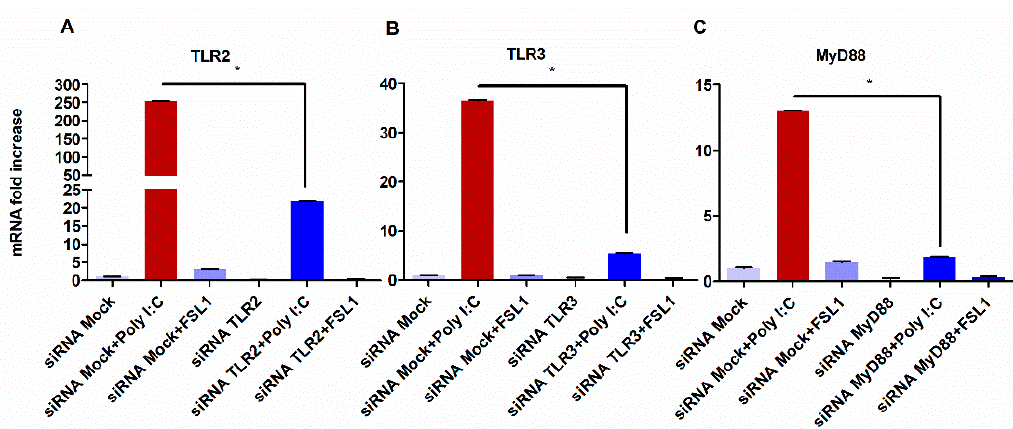
Figure 6. TLR3 stimulation induced MyD88 and inhibition attenuated its expression: the HGECs were treated with respective ligands after silencing TLR2, TLR3 and MyD88. Silencing TLR3 induced significantly higher TLR2 expression even when TLR2 was silenced ( A ). As expected, siTLR3 treated the cells’ downregulated TLR3 ( B ). Interestingly, poly I:C-treated cells significantly increased Myd88 expression ( C ). However, when MyD88 was silenced, poly I:C significantly downregulated MyD88 expression. The extent of poly I:C increasing TLR2 expression was relatively higher than that of FSL-1 increasing TLR3 expression. Statistical test: one-way ANOVA followed by Tukey’s multiple comparison test (* p < 0.05) and the results are represented as the mean ± SE ( n = 3) from three independent